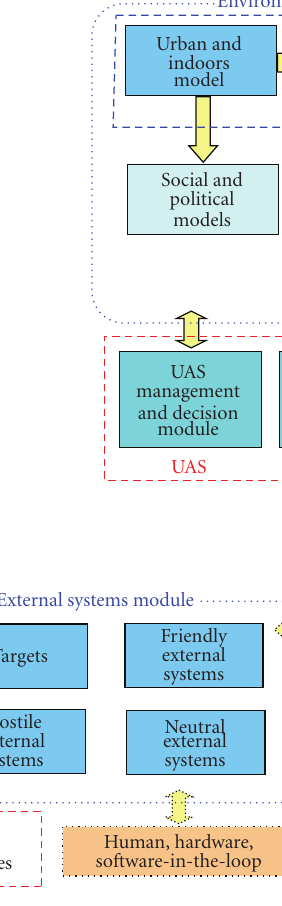
Figure 10: UAS-SE—external systems